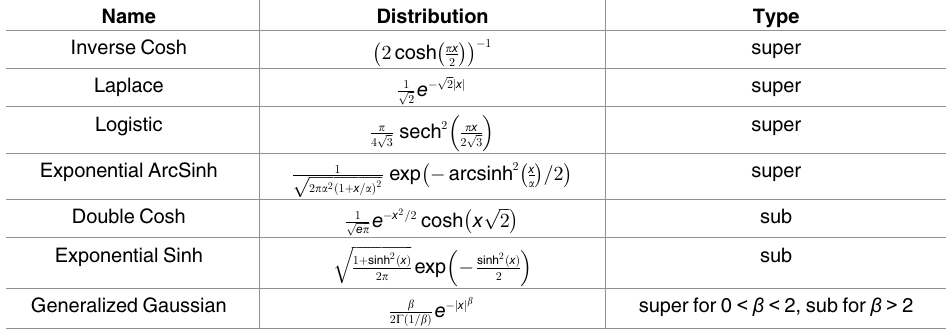
Table 1. Simulated sparse sources used in this